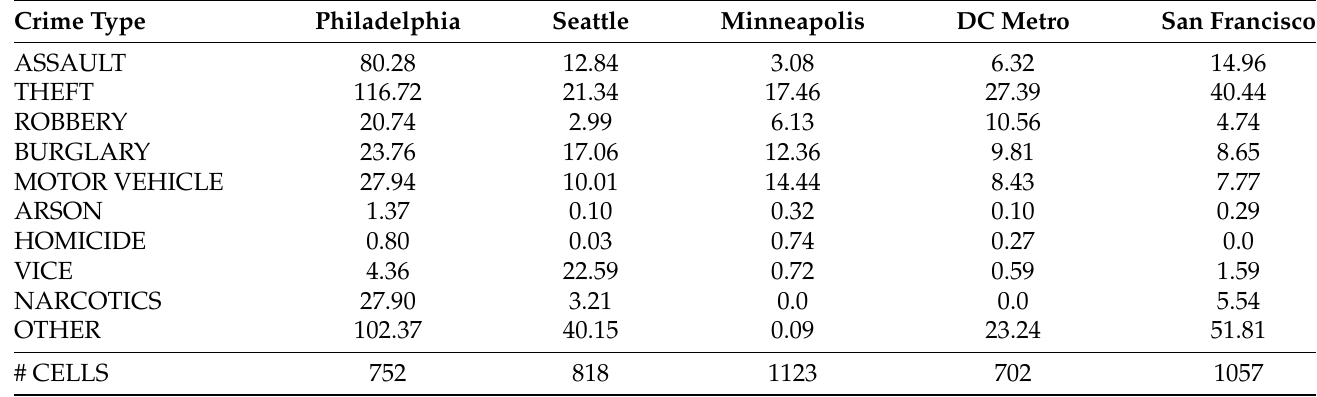
Table 3. Mean number of hotspots per day for every crime type and dataset for the highest resolution of 40 cells by 40 cells. Crime